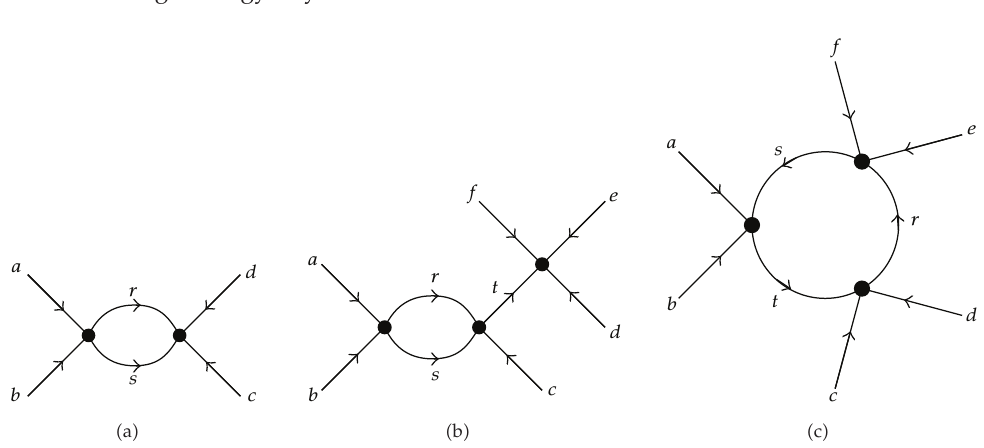
Figure 8: One-loop diagrams. The labels r, s , and t count the derivatives acting onto the corresponding internal